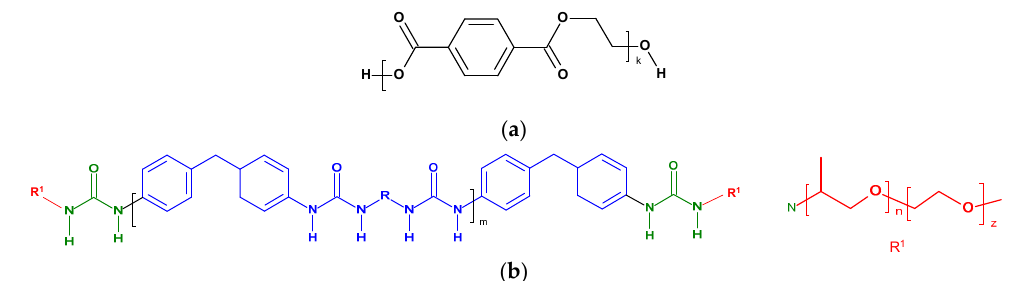
Figure 1. The structures of polymer components of polyethylene terephthalate-elastane (PETE). ( a ) Polyethylene Terephthalate (PET) (k, m, n, z-the degree of polymerization). ( b ) Elastane (EA) (ABA polyether–polyurea–polyether block copolymer; R= linear, cyclic or aromatic diamine chain exchanger; m = 29; z = 6) according to Locatelli et al. [110].